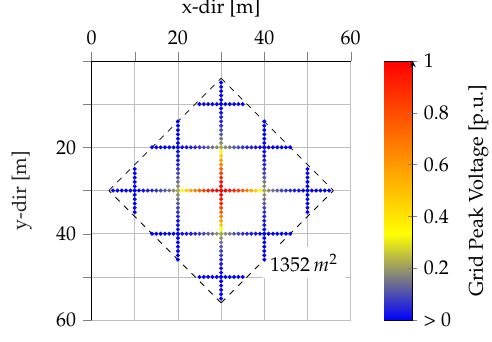
Figure 10. Application case: used area.